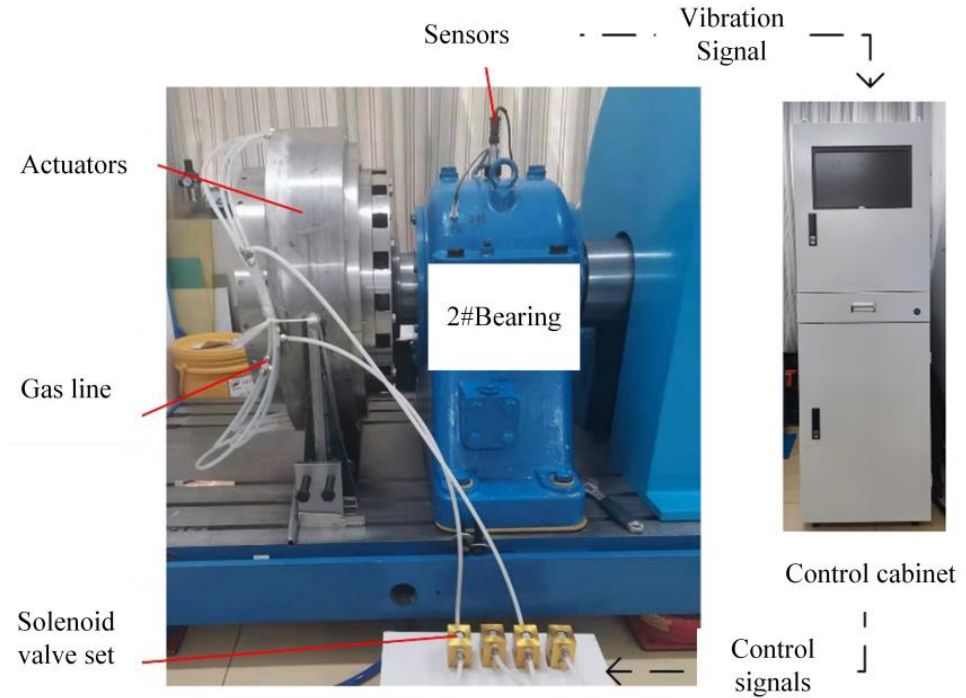
Figure 16. Building an automatic balancing system.